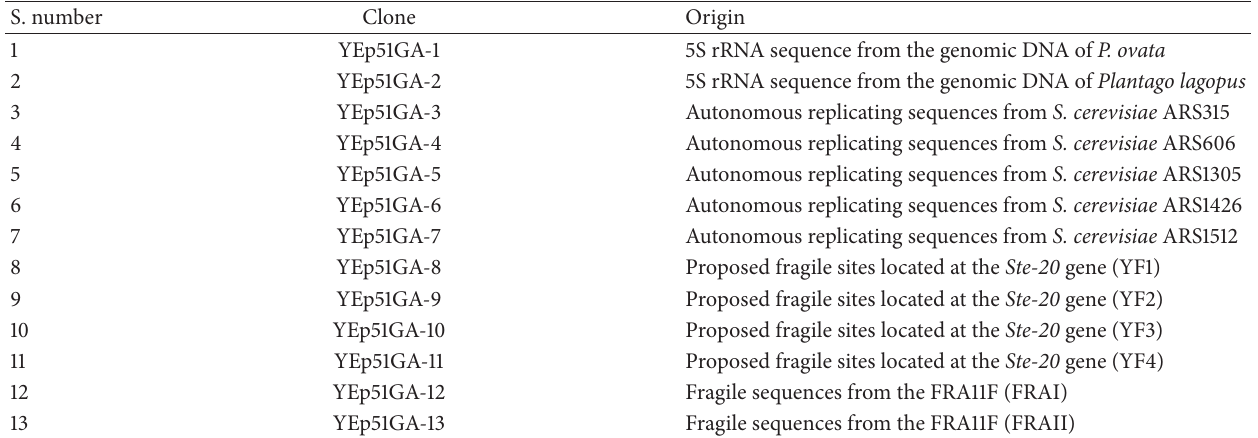
Table 4: APS from different sources used for the present